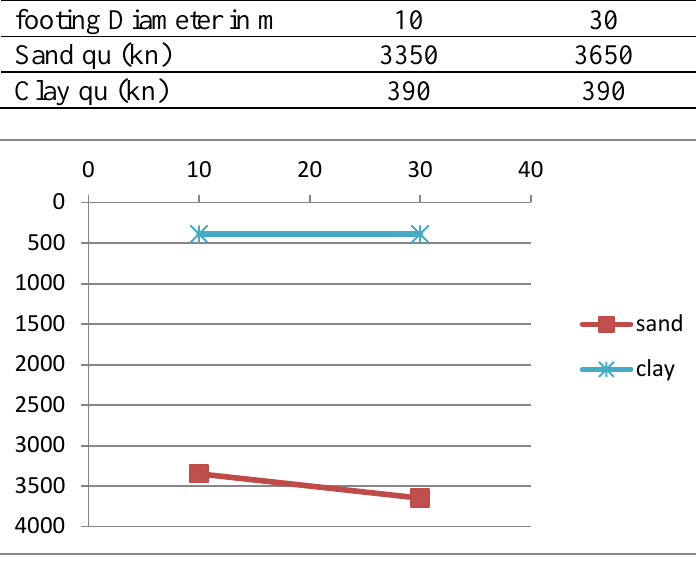
Fig. 6. Bearing Capacity footing size relationship.